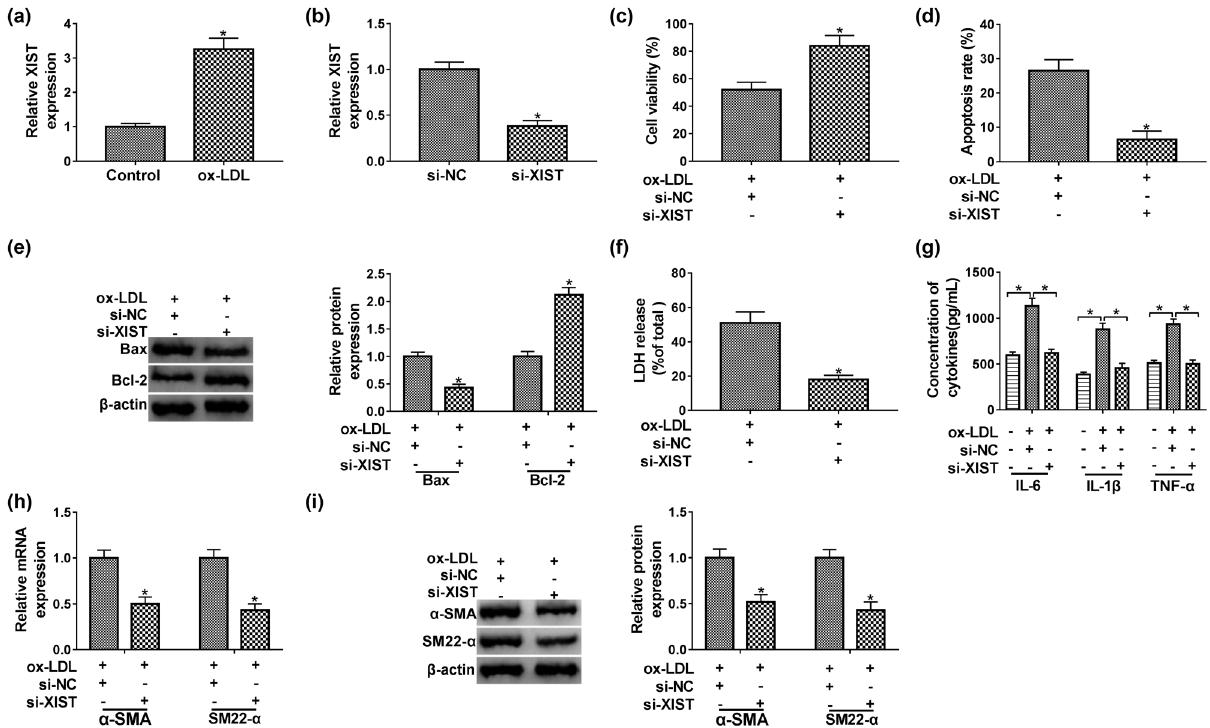
Figure 2: Knockdown of XIST weakened ox - LDL - induced e ff ects on HUVECs. ( a ) The expression level of XIST in HUVECs treated with ox - LDL was determined by qPCR analysis. ( b ) The interference e ffi ciency of si - XIST in HUVECs was assessed by qPCR assay. ( c – f ) HUVECs were divided into two groups: ox - LDL + si - NC and ox - LDL + si - XIST groups. ( c ) The proliferation capability of HUVECs was measured using MTT assay. ( d ) The fl ow cytometry assay was recruited to monitor the apoptosis of HUVECs. ( e ) The western blot analysis was applied to assess Bax and Bcl - 2 expression inHUVECs. ( f ) A commercial availablekit was used to assess LDH release in HUVECs supernatants. ( g ) The expression levels of IL - 6, IL - 1 β , and TNF - α in ox - LDL - induced HUVECs were displayed, with 0 μ g/mL of ox - LDL group as control. ( h and i ) QPCR and western blot analyses were employed to quantify mRNA and protein levels of α - SMA and SM22 - α in HUVECs, respectively. Data shown are mean ± SD and from three independent experiments. * P < 0.05. Abbreviations: X - inactive - speci fi c transcript ( XIST )